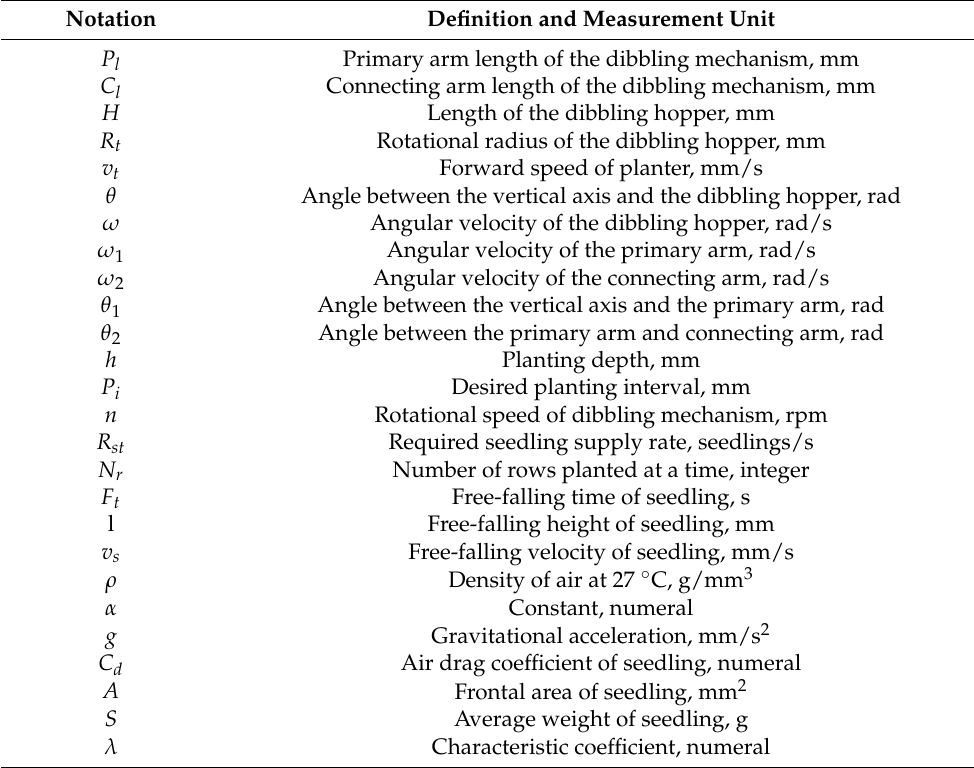
Table 1. Variable notations, definitions, and measurement